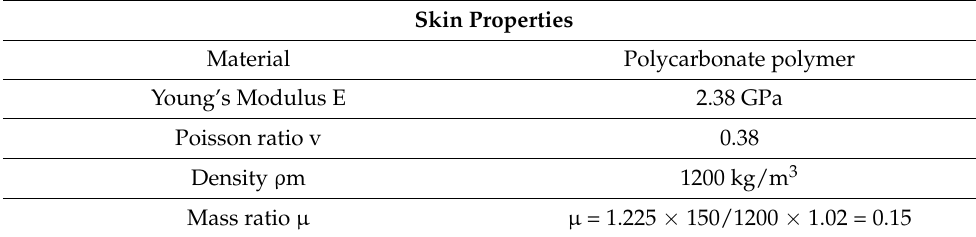
Table 1. Polycarbonate polymer properties of the prototype skin. Skin Properties